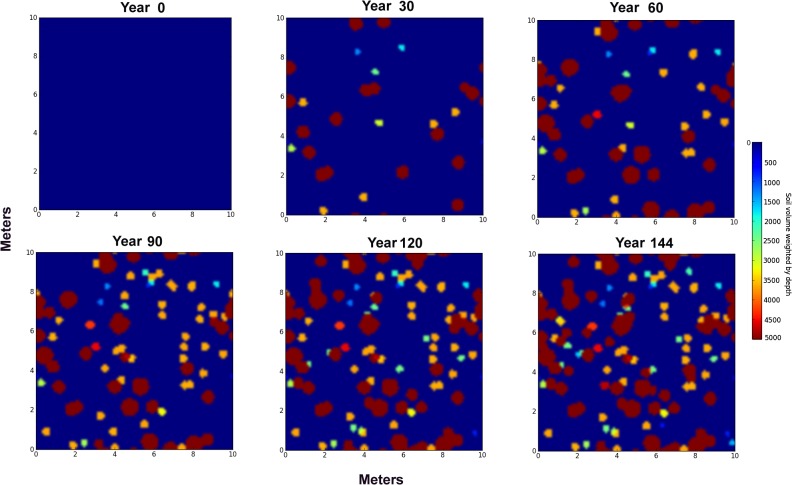
Simulation of a single colony in 100 m2.Simulation was run until 25% of the area was covered by discs, about 145 years. Densities this high probably rarely occur in nature, but illustrate the principles of the simulation. Blue indicates a shallow source of soil, while red indicates admixture of deepest layers. Colonies move a mean of 4 m per year in random directions (see text for details).